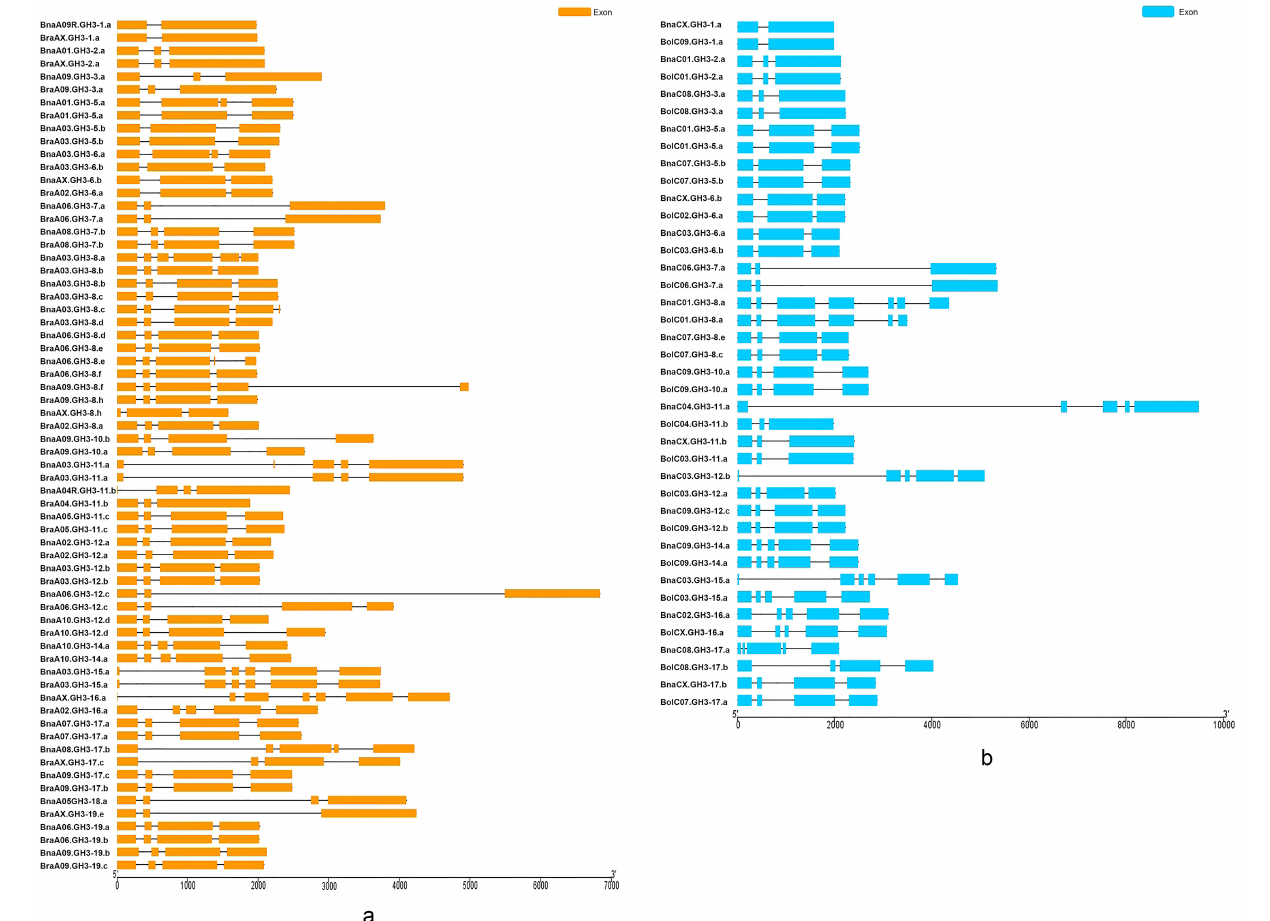
Figure 5. The exon–intron compositions of 33 GH3 A n -A r orthologous pairs and 20 GH3 C n -C o orthologous pairs. ( a ) Thirty-three GH3 A n -A r orthologous pairs; ( b ) twenty GH3 C n -C o orthologous